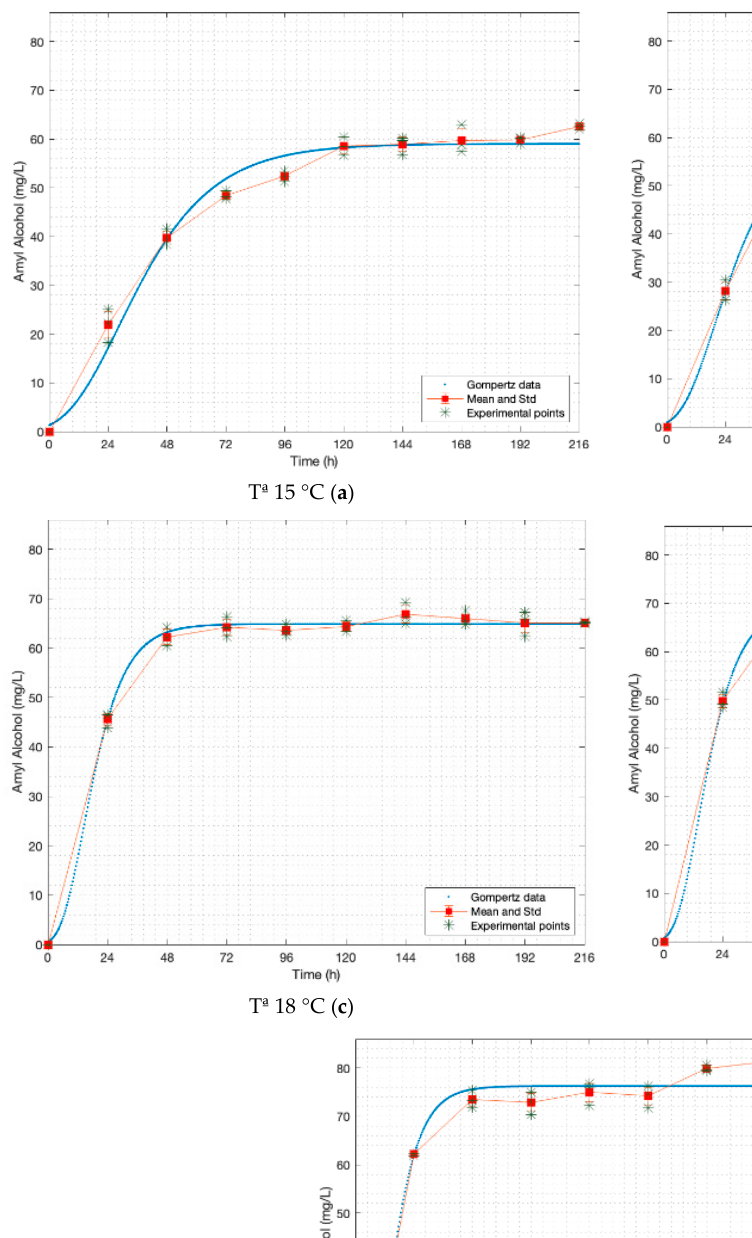
Figure 3. Gompertz graphs of predicted values for ethyl acetate. ( a ) Dataset 15 °C; ( b ) dataset 16.5 °C; ( c ) dataset 18 °C; ( d ) dataset 19 °C; ( e ) dataset 21 °C. Blue lines represent the Gompertz function. Asterisk represents experimental raw data. Squares and red lines represent the means and standard deviations.